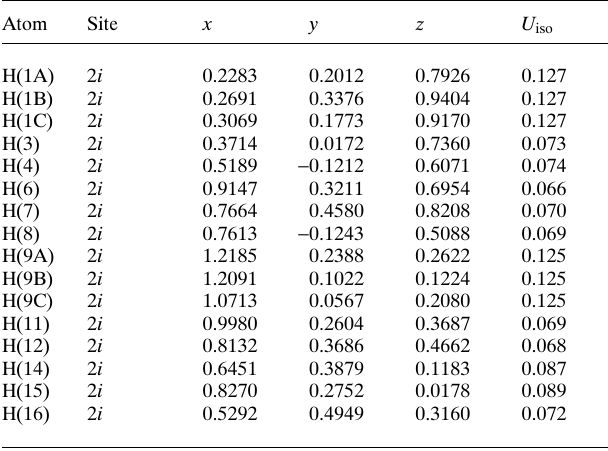
Table 2. Atomic coordinates and displacement parameters (in Å 2 )